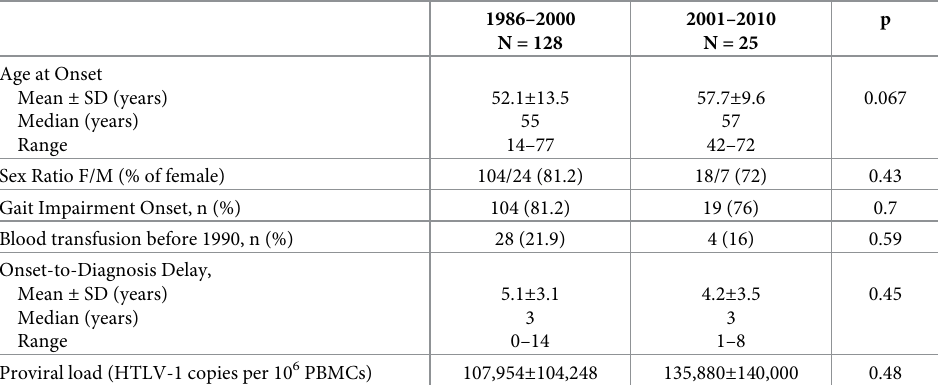
Table 3. HAM/TSP characteristics according a disease onset in 1986–2000 and 2001–2010